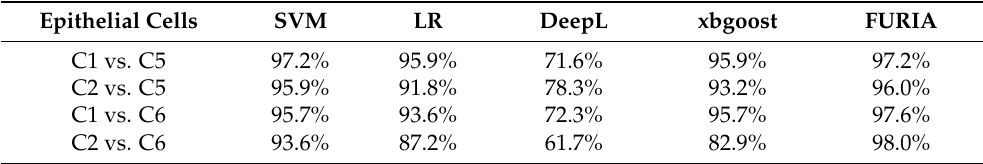
Table 1. Percentage of accuracy for the di ff erent algorithms considering MMPs/TIMP-3 expression by epithelial cells.